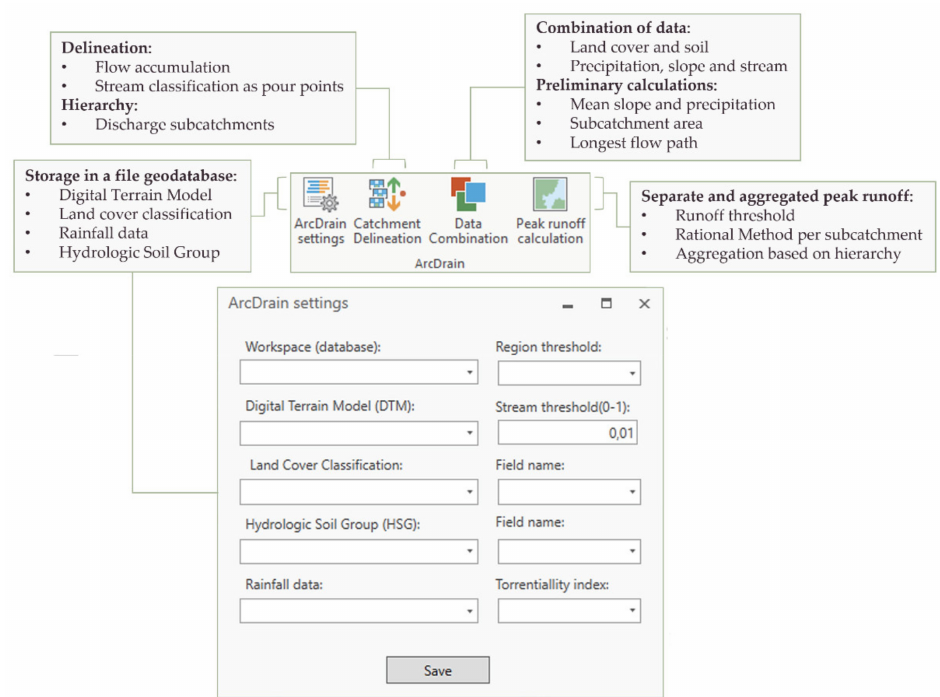
Figure 1. Breakdown of the ArcDrain ribbon into four modules, and their main